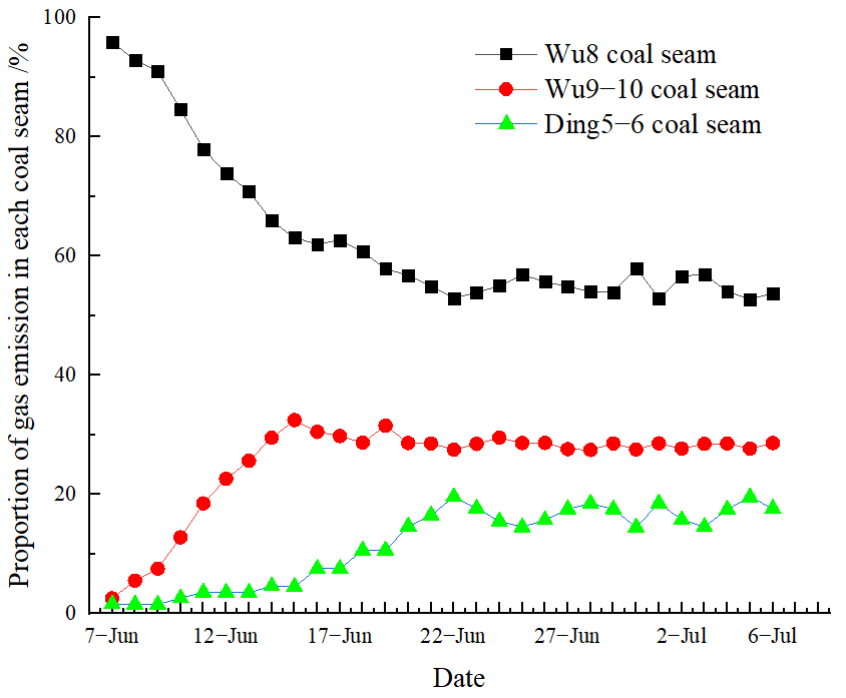
Figure 5. Gas emission proportion of each coal seam in the upper corner.